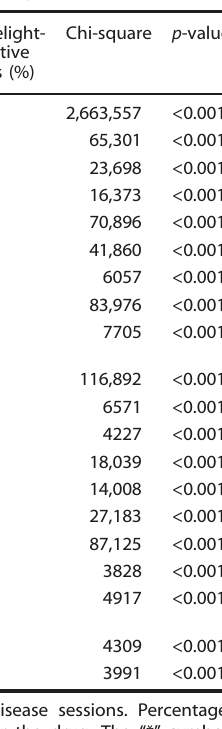
Table 1. Searches for drugs associated with Lyme disease